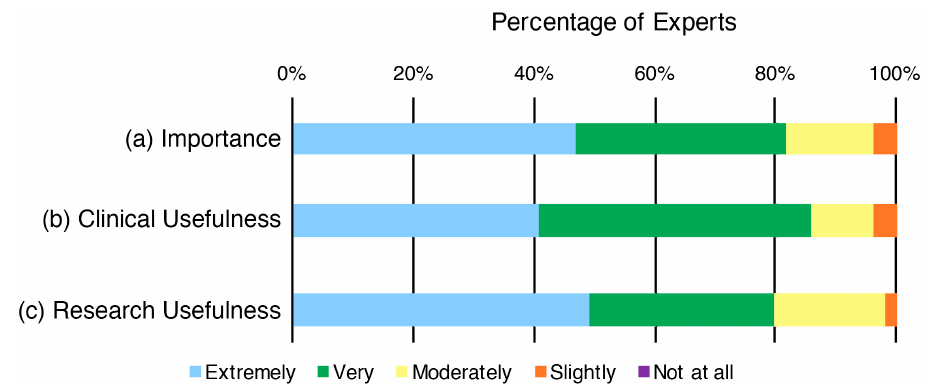
Figure 1. Distribution of pediatric pain experts’ ratings of (a) importance; (b) clinical usefulness; and (c) research usefulness of assessing a child’s concept of pain in children aged 8–12 years.